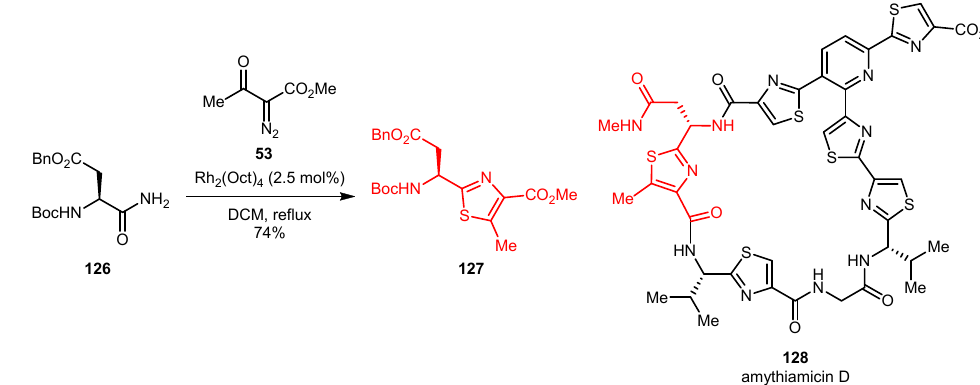
Scheme 28. Preparation of thiazole 127 from amino acid amide and diazo compound in the total synthesis of amythiamicin D.